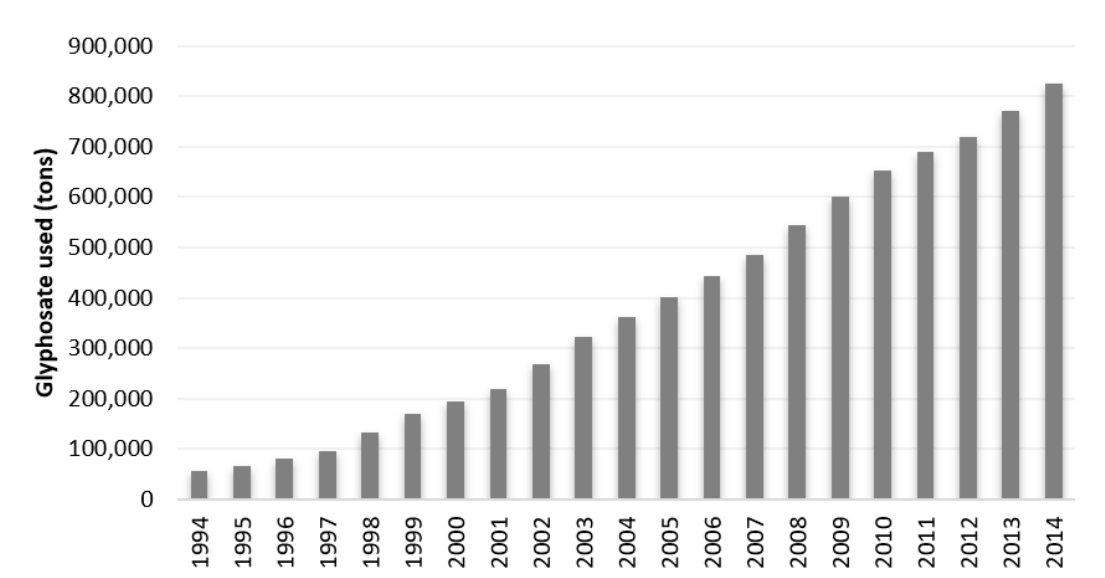
Figure 2. Evolution of annual glyphosate consumption worldwide between 1994 and 2014.